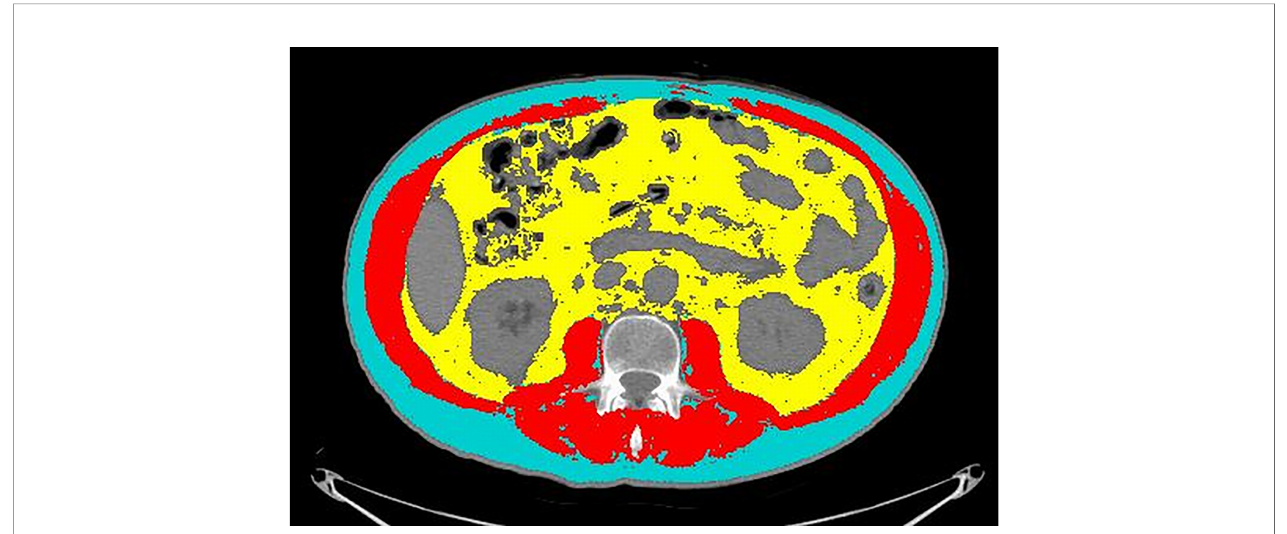
FIGURE 1 | An example of segmentation of the CT image at the level of L3. Cyan indicates visceral adipose tissue (VAT) area; red indicates skeletal muscle area (SMA); yellow indicates visceral adipose tissue (VAT). Grey areas were excluded from measurements because they refer to abdominal organs (mainly liver, kidneys, and